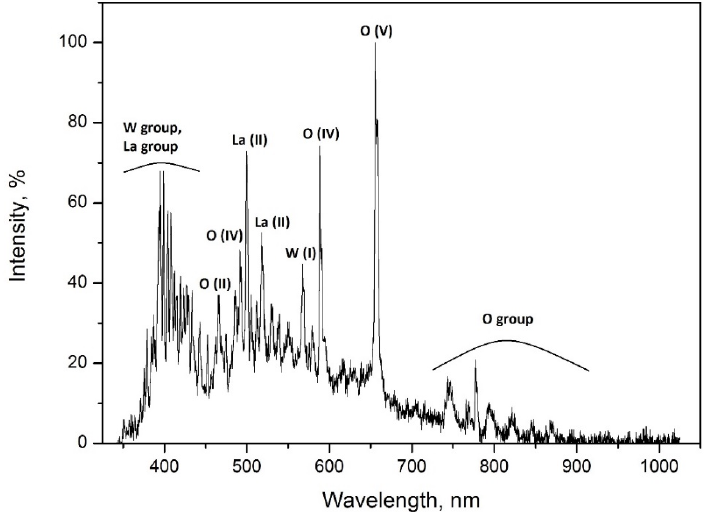
Figure 8. Spectrum recorded from plasma induced by laser pulse (wavelengths from 200 to 1100 nm).